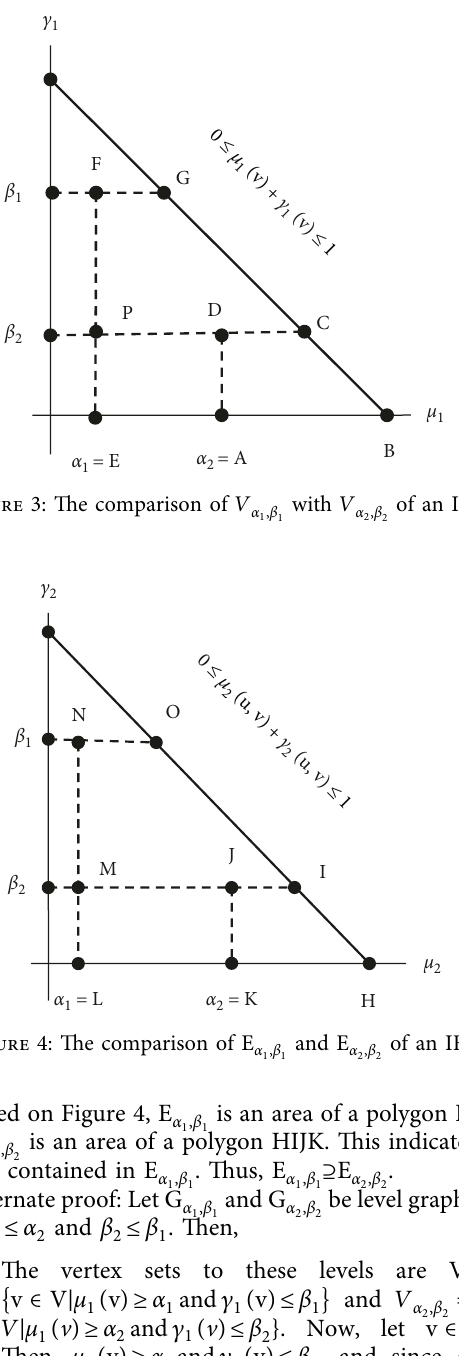
and E of an IFG. α 1 , β 1 α 2 , β 2